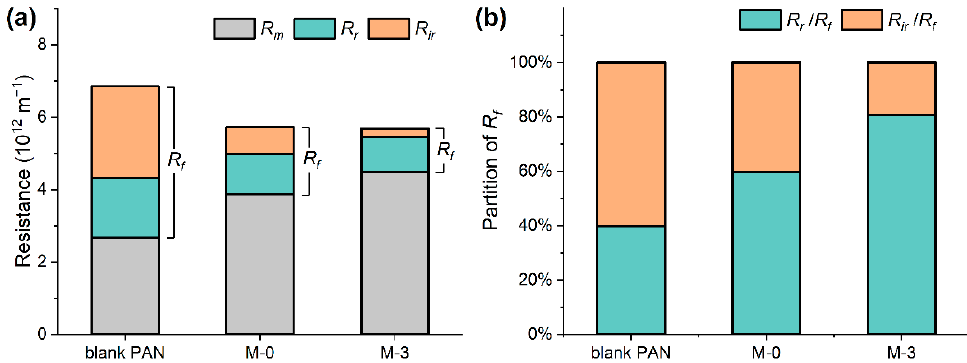
Figure 11. ( a ) Filtration resistance ( R m , R r and R ir ) of the blank PAN, M-0, and M-3 membranes; ( b ) the partition of the total resistance of fouling ( R f ).